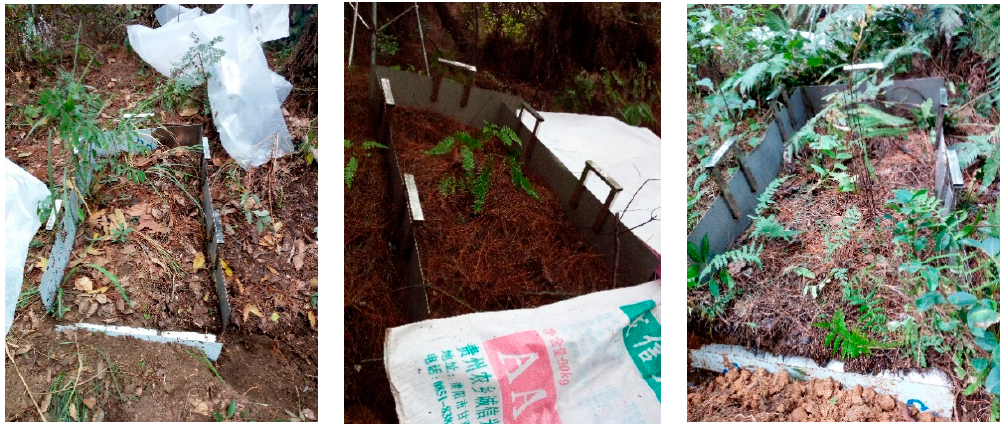
Figure 2. Micro-runoff plot setup in the forest.